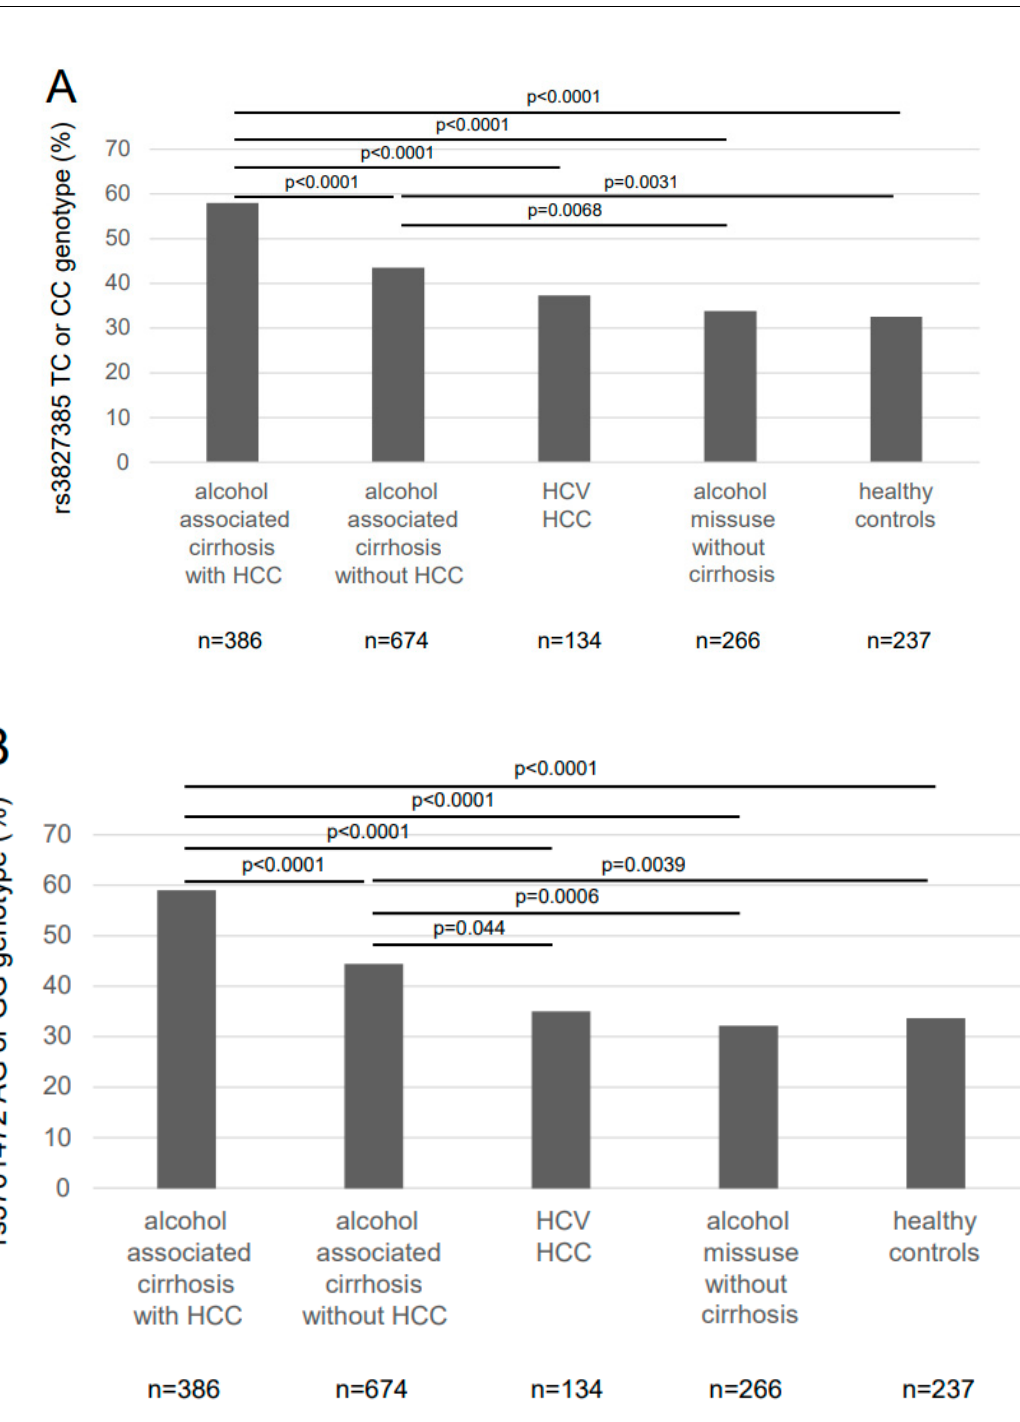
Figure 1. Proportion of carriers of a SAMM50 minor allele among the study cohorts. Carriers of the minor allele are over-represented among patients with alcoholic hepatocellular carcinoma (HCC) versus all other cohorts and among patients with alcohol-associated cirrhosis versus controls without liver disease. ( A ) proportion of patients carrying a SAMM50 rs3827385 genotype containing the minor allele C among the study cohorts. ( B ) proportion of patients carrying a SAMM50 rs3761472 genotype containing the minor allele A among the study cohorts. Statistical analysis with Pearson’s goodness-of-fit Chi2 test. Abbreviations: HCC hepatocellular carcinoma; HCV hepatitis C virus; SAMM50 Sorting and assembly machinery component 50 homolog.